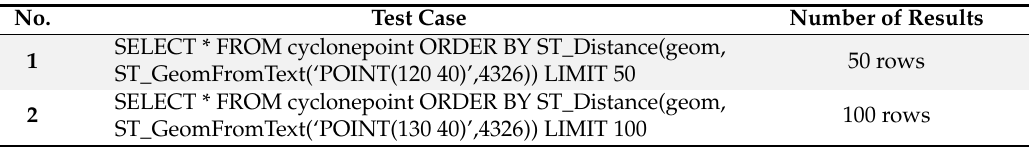
Table 7. Performance of kNN queries (in milliseconds).